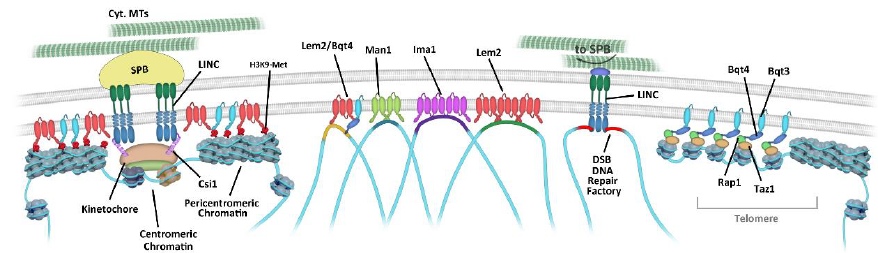
Figure 2. NE microdomains and their association with different genomic regions. Schematic representation of the linkage between centromeres, telomeres, double strand breaks (DSBs) and other genomic loci and INM proteins. DSB repair factories are linked to the NE by the LINC complex and can be moved by cytoplasmic MTs and positioned in close proximity of the SPB. The different elements are depicted as in Figure 1.